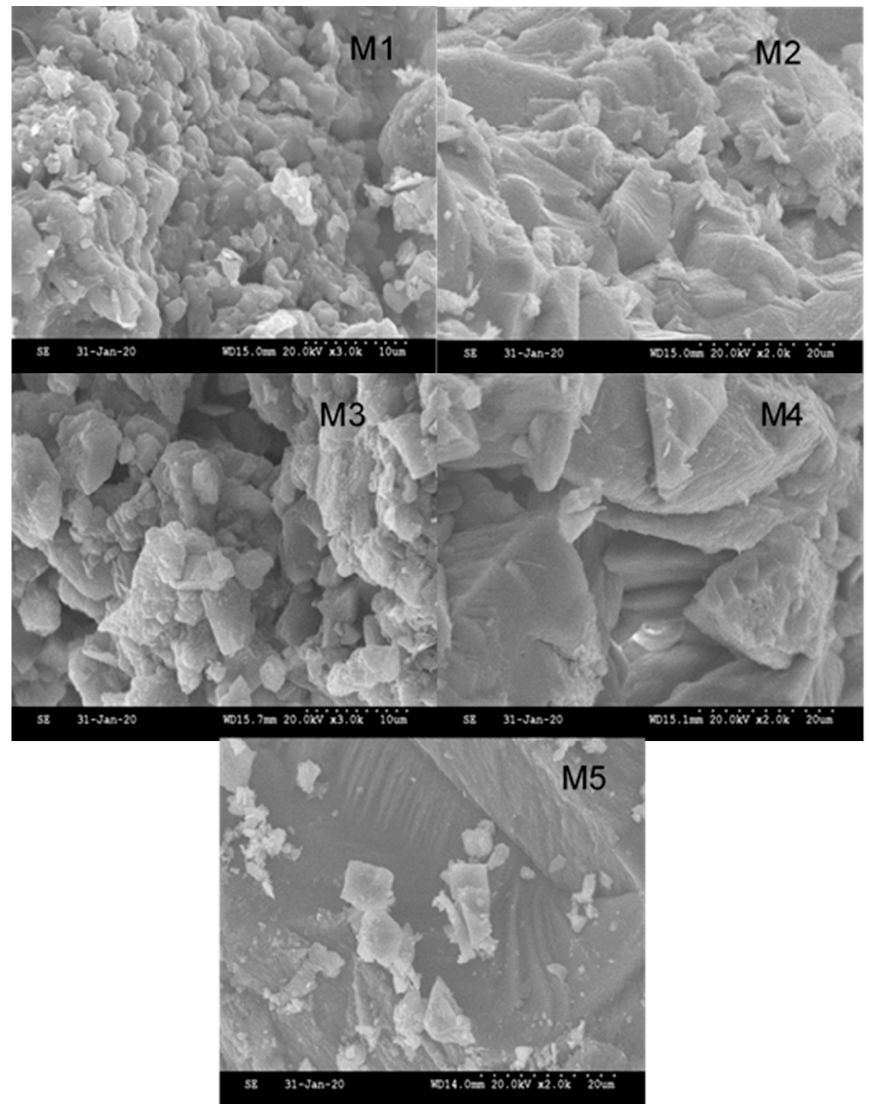
Figure 6. SEM photographs of crystals grown in asbestos, M1, and PVC pipes from M2 to M5.